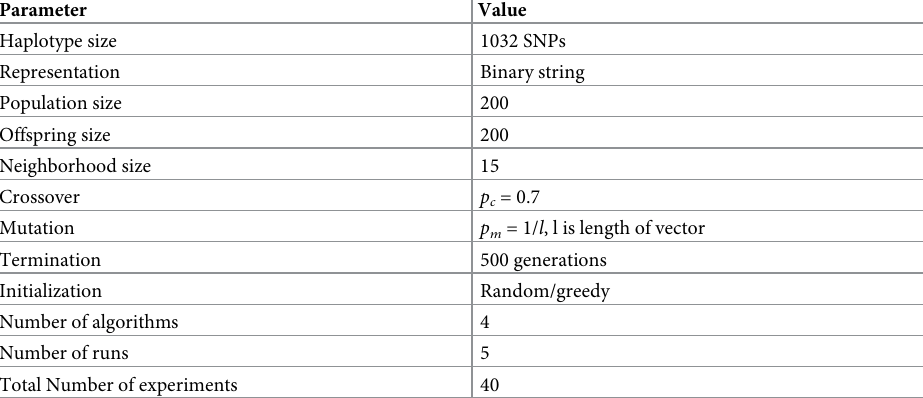
Table 2. Parameter setting for experiments of many-objective evolutionary algorithms. These parameters are set according to the study